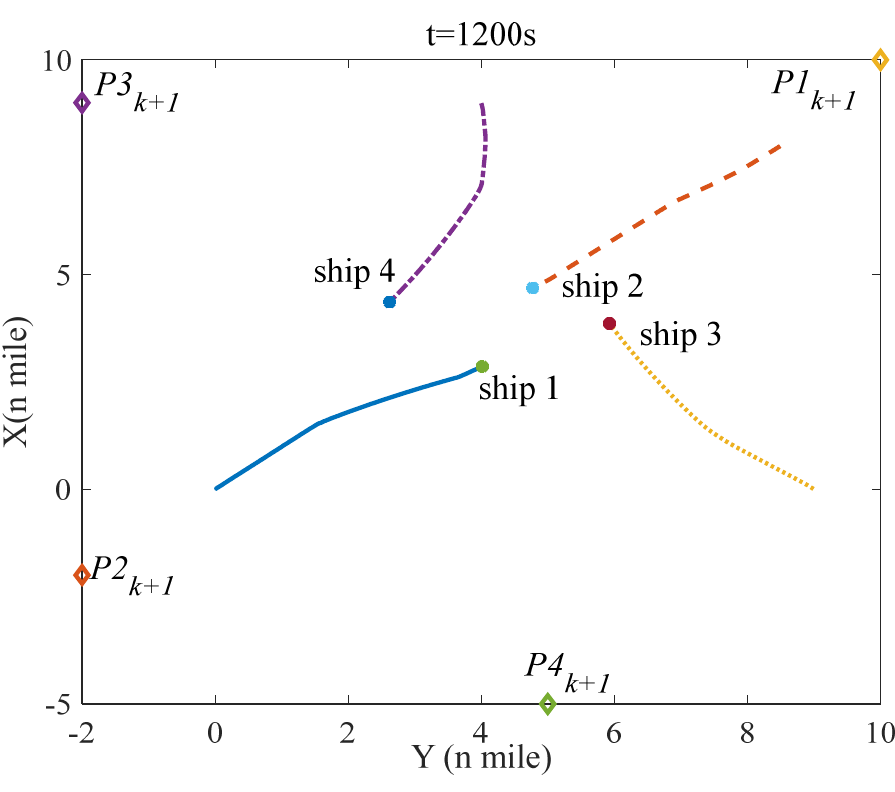
Figure 7. The situation of four ships at t = 600 s in scenario 1.